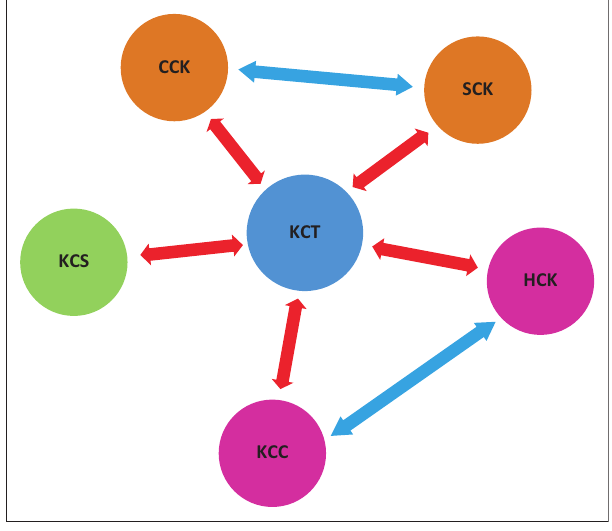
FIGURE 3: How the mathematics knowledge for teaching domains relate to each other. SCK, Specialised content knowledge; KCT, knowledge of content and teaching; KCS, knowledge of content and students; KCC, knowledge of content and curriculum; HCK, horizonal content knowledge; CCK, common content